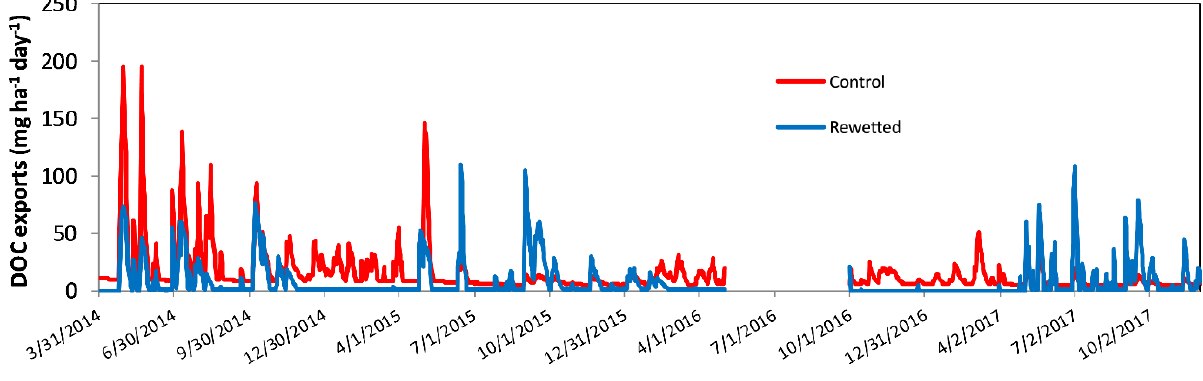
Figure 6. Simulated DOC exports for control and rewetted sites.